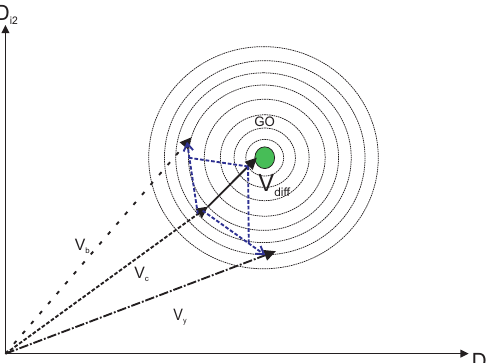
Figure 6. Generation of V dif f with initial population